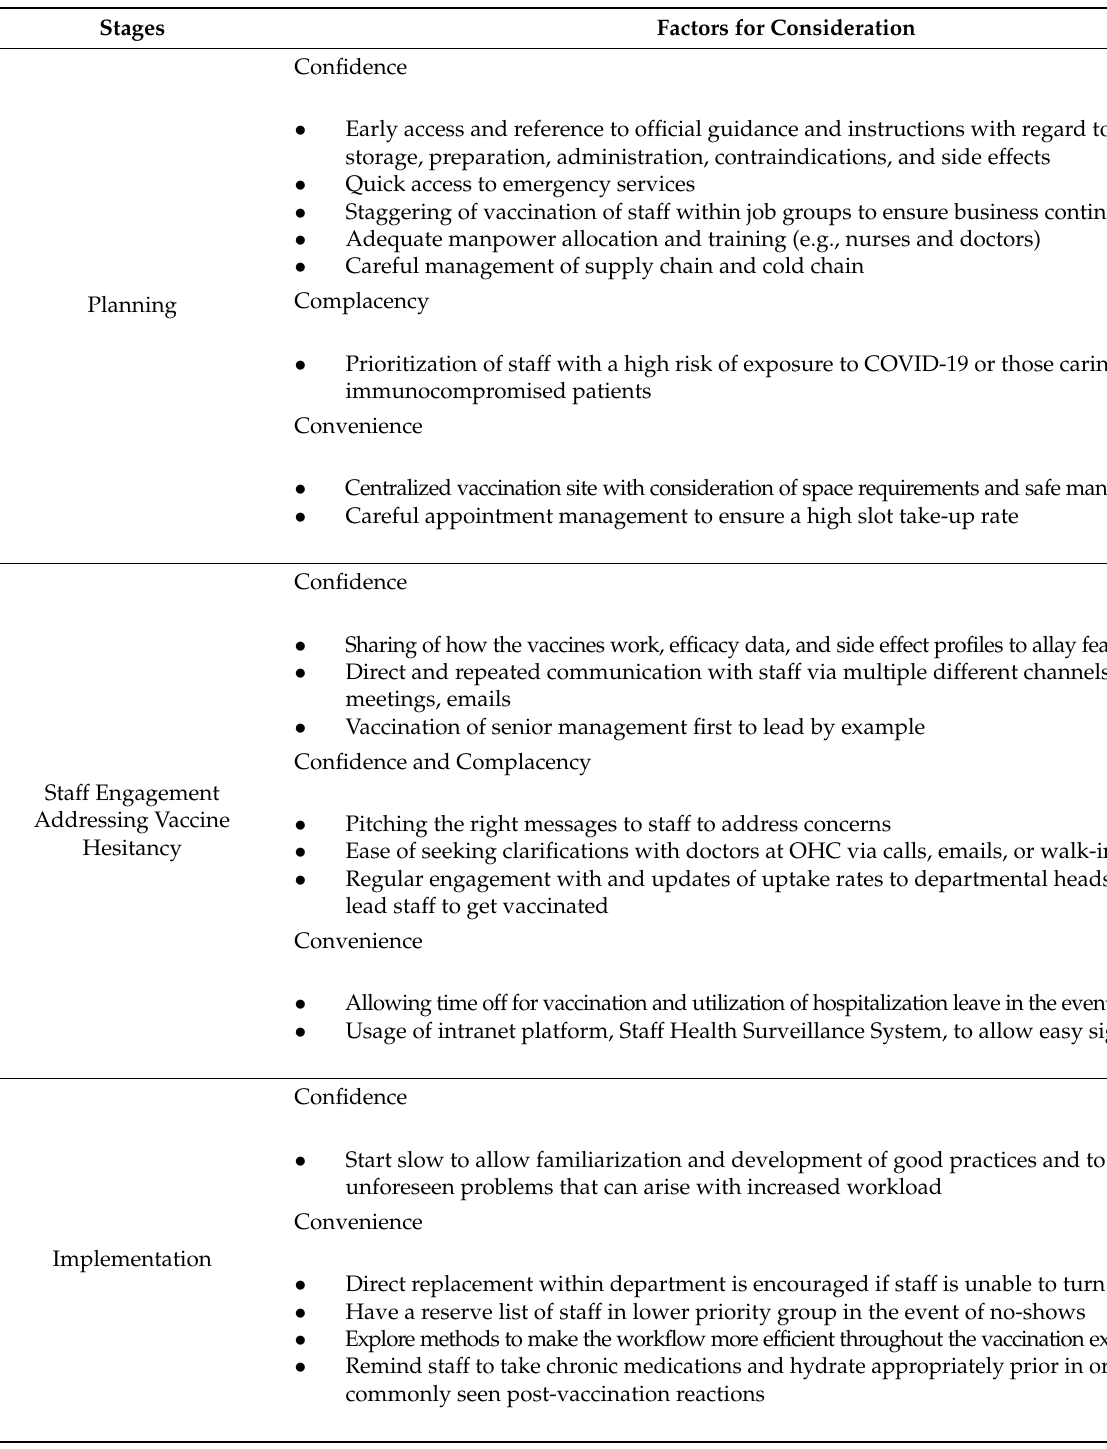
Table 1. Factors for consideration in the roll-out of staff COVID-19 vaccination exercise in a tertiary hospital based on the ‘3Cs’